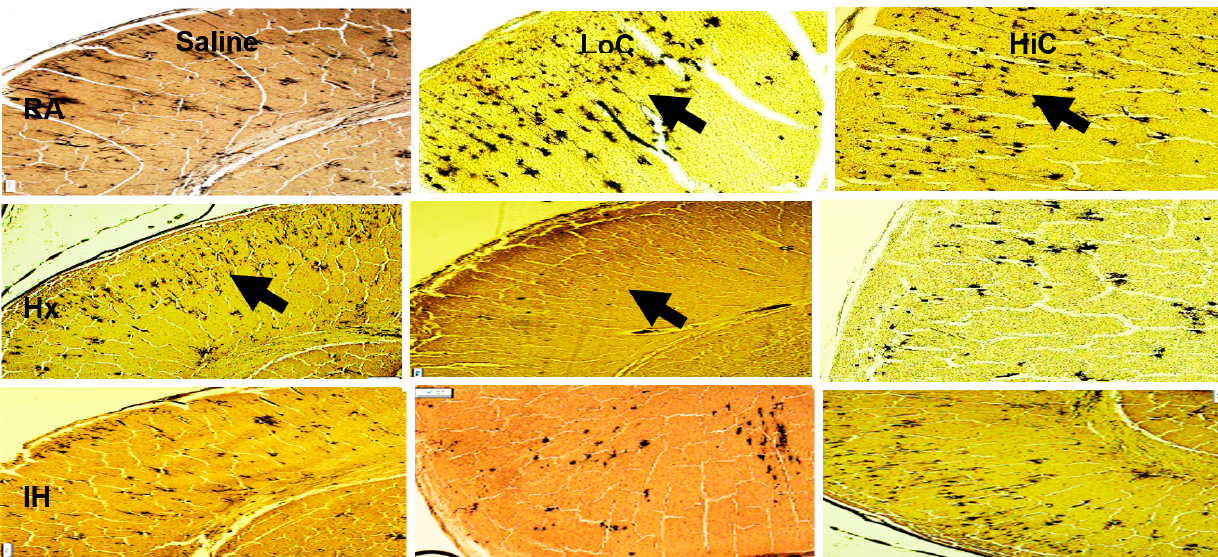
Figure 11. Representative Golgi stain of neurons in the cerebral cortex at P14. Groups are as described in Figure 1. Images are 20× magnification, bar scale is 50 µm. Staining of golgi bodies increased in Hx with placebo saline (arrow), and with LoC and HiC in RA (arrow). However, exposure to caffeine in Hx and neonatal IH decreased golgi staining, consistent with placebo saline.